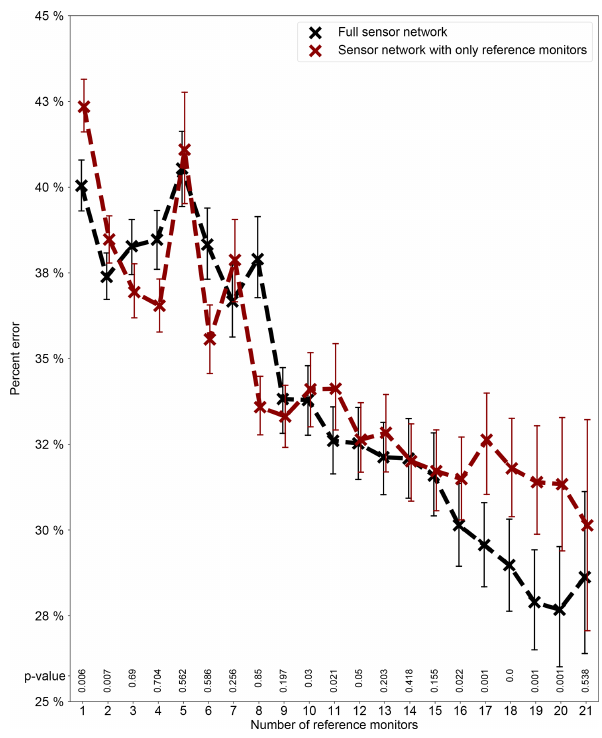
Figure 10. Average 24h percent errors of the GPR model for pre- dicting the holdout reference nodes in the network as a function of the number of reference stations used for the model construction under two scenarios – using the full sensor network information by including both reference and low-cost nodes and using only the reference nodes for the model construction. Note each data point (mean value) is derived from 100 simulation runs. The error bars indicating 95% confidence interval (CI) of the means are based on 1000 bootstrap iterations. All scenarios were given the initial pa- rameter values and bounds that maximize the model performance. The p value of the Wilcoxon rank-sum test for each reference sta- tion number is superimposed, where a p value below 0.05 means that the error when modeling with the 10 low-cost nodes is smaller than the error without them for that reference station